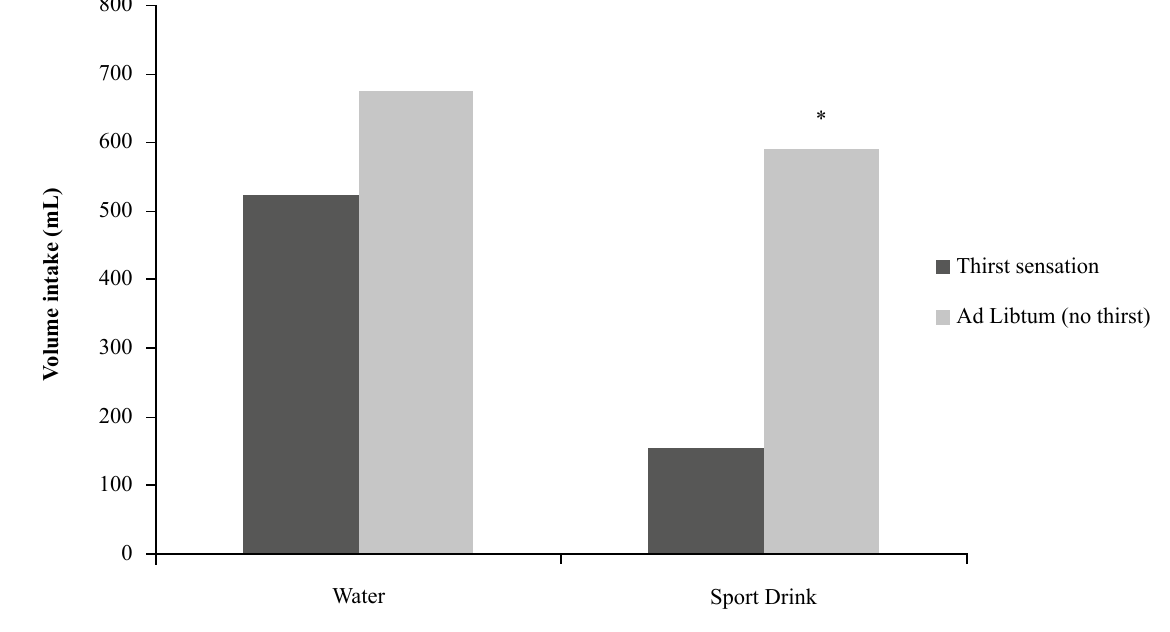
Figure 1: Total volume of fluid intake during training with and without sensation of